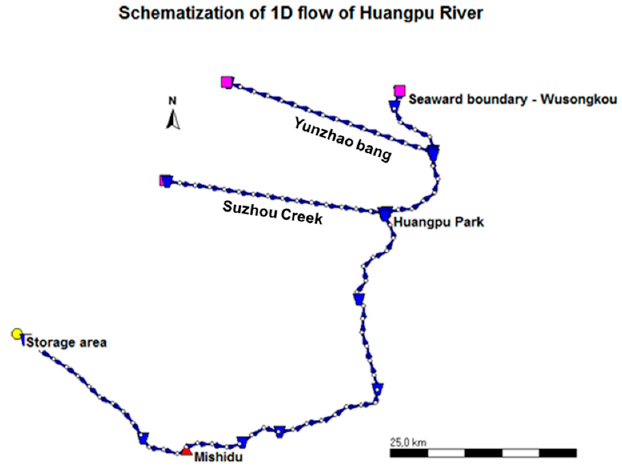
Figure 2. Schematization of 1D Flow of macro water system of Huangpu River.